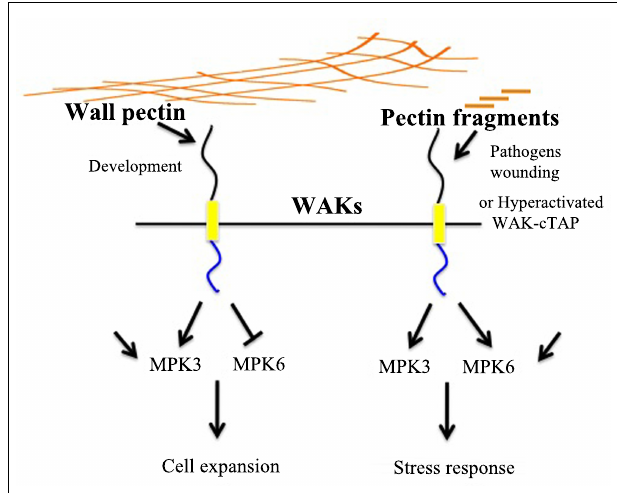
FIGURE 1 |A model for pectin–WAK regulation of growth and the stress response. Cartoon of pectin in the cell wall (long brown lines) activatingWAK in the plasma membrane, and subsequent activation of MPK3. MPK6 is either repressed or not activated, and downstream gene activation leads to cell growth. In the presence of OGs, fragmented pectins, generated by pathogens or wounding,WAKs now activate MPK6 as well as MPK3, and the subsequent change in gene expression leads to a stress response. MPK6 and MPK3 are activated by many other pathways, as indicated by black arrows not originating